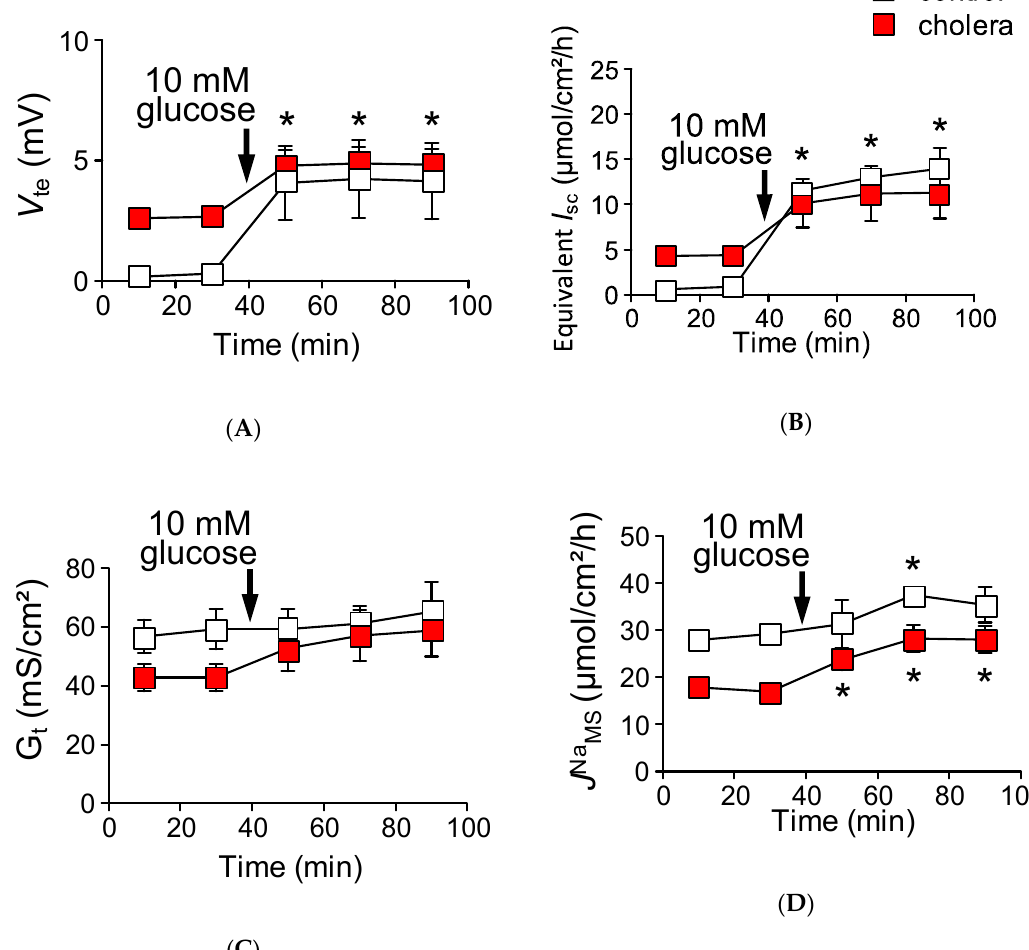
Figure 8. Robust glucose-induced J Na MS is observed in cholera toxin-diarrhea model mice under open-circuit conditions: Glucose-induced V te ( A ), equivalent I sc ( B ), and ∆ J Na ( D ) were measured simultaneously under open-circuit conditions. Equivalent I sc was determined the same as in Figure 3. G t ( C ) was determined from transepithelial potential di ff erence ( V te ) and current pulse by applying Ohm’s law. Open squares indicate control conditions (without cholera toxin) and closed squares indicate cholera toxin treated conditions ( n = 3 and 5, control and cholera toxin treated mice, respectively). Where indicated by the arrows, glucose was added to the mucosal side. Each point represents the mean ± SE. Where error bars are absent, they are smaller than the symbol used. * p < 0.05 as compared with the baseline control.